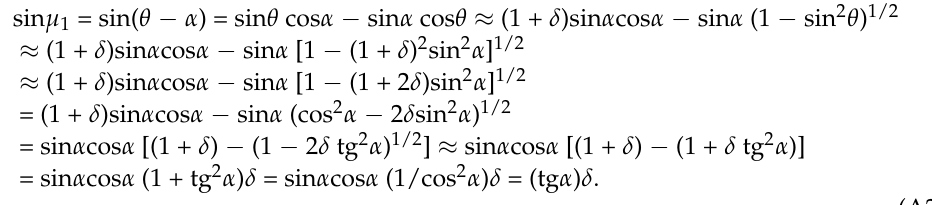
Figure 29. Another early result of SYNAPSE [10].